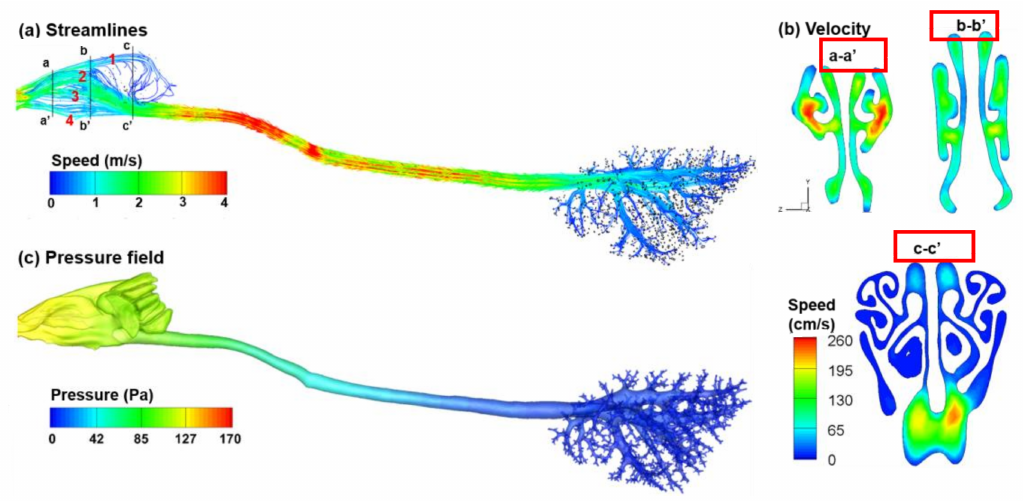
Figure 1. Airflow in the rat airways: ( a ) streamlines; ( b ) cross-sectional velocity distribution in the rat nose; and ( c ) pressure field.